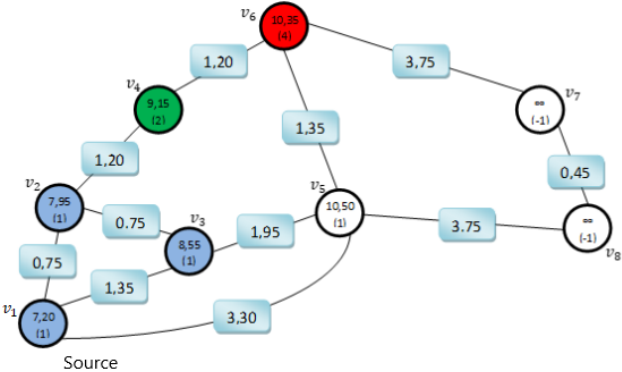
Figure 7. Finding the optimal path from peak 1—step 4.